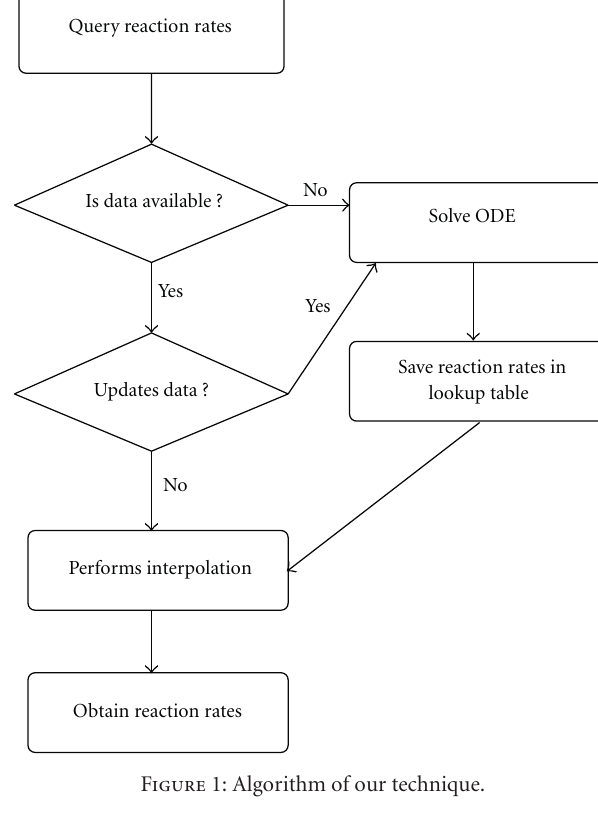
Figure 1: Algorithm of our technique.